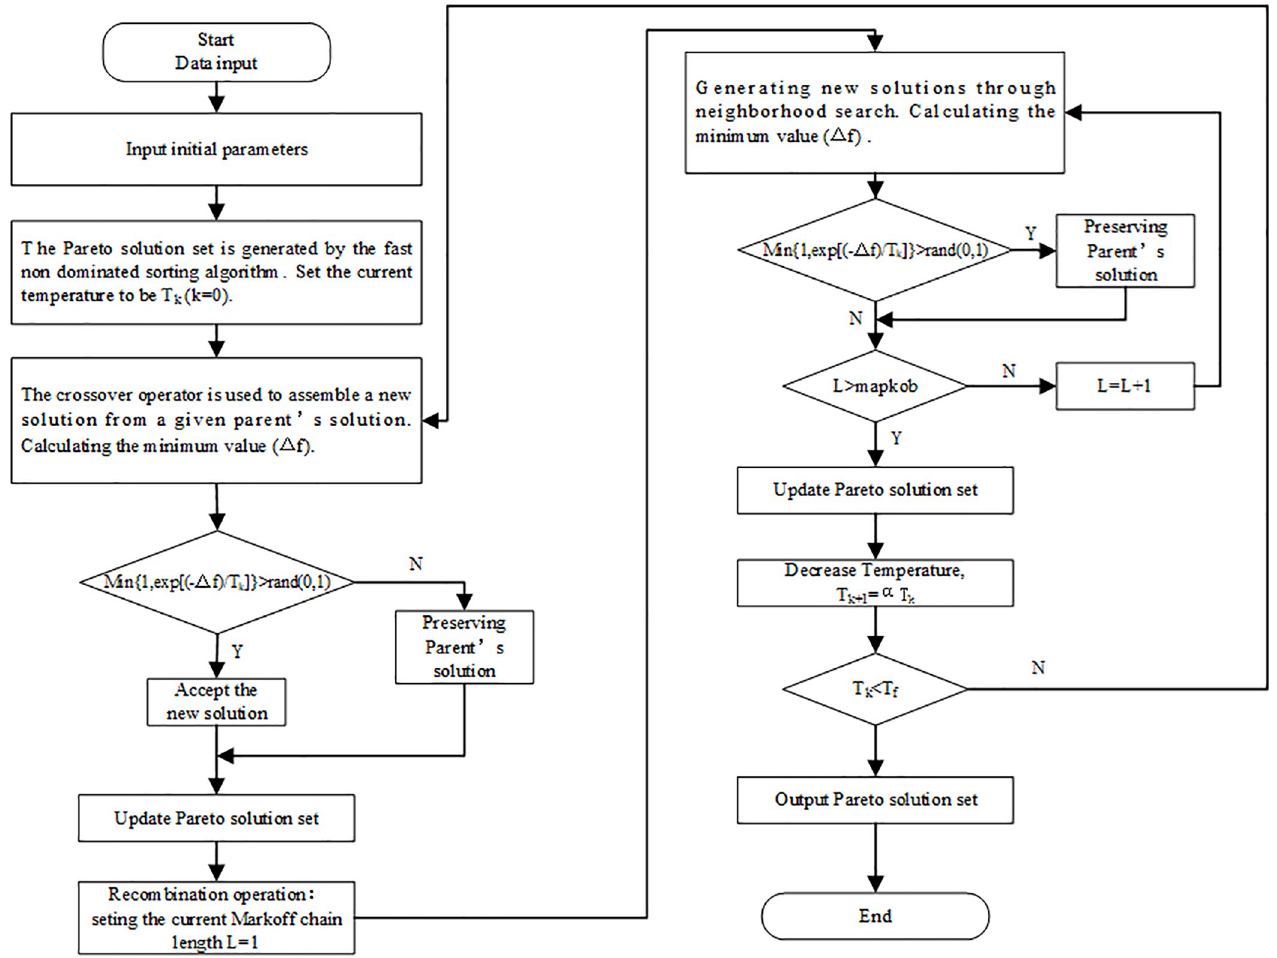
Fig 1. The overall flowchart of IMOSA